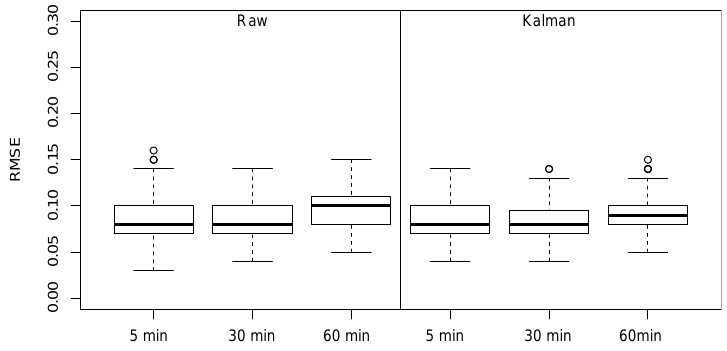
Figure 11. Performance boxplots with clustered segments and 1000 sample size.